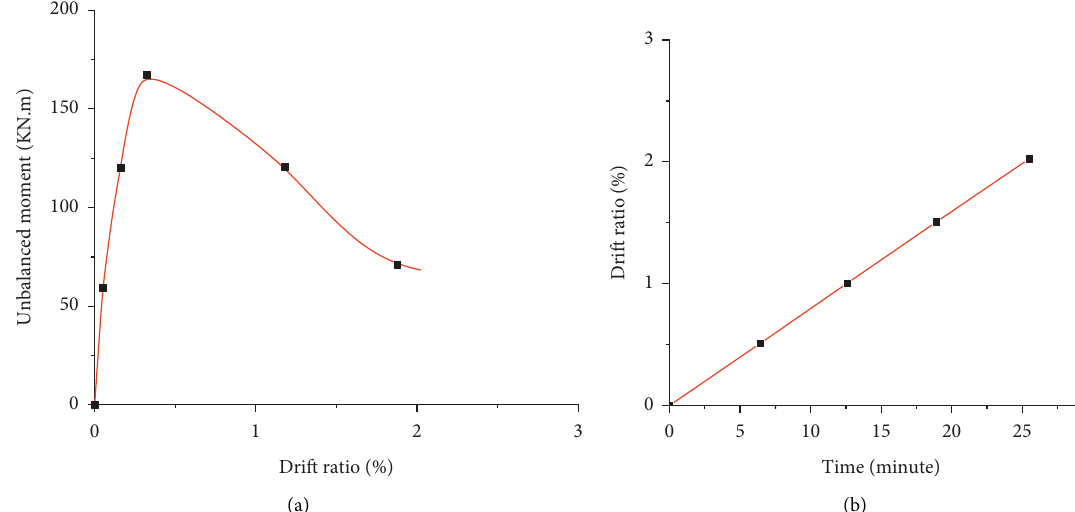
Figure 27: (a) Unbalanced moment drift ratio response and (b) drift ratio-fre exposed duration response of 10% axial load level.